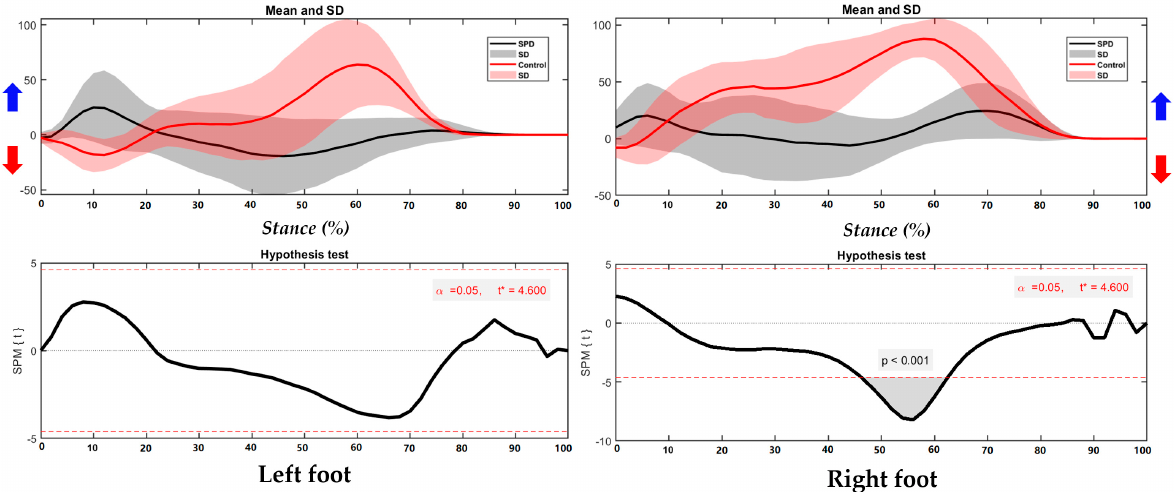
Figure 5. FBI in the left foot and right foot during running with highlighted directions of pronation (blue arrow) and supination (red arrow).